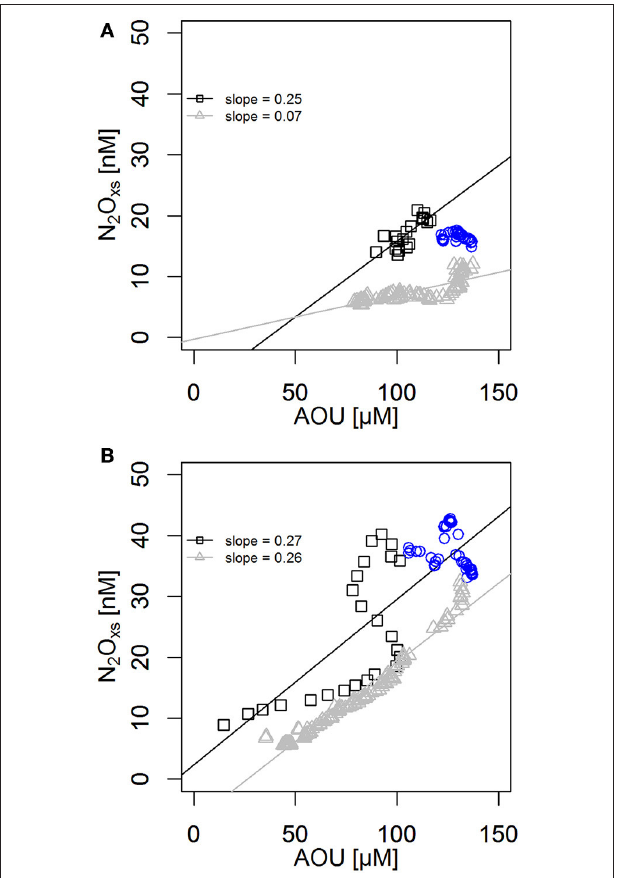
FIGURE 5 | Relationship between N 2 O excess (N 2 O xs ) and apparent oxygen utilization (AOU) in the Elbe river with according regression slopes in April (A) and June (B) . (cid:3) , Elbe river upstream of the region with lowest O 2 concentration; 1 , Elbe river downstream of the region with lowest O 2 concentration region; o, within the oxygen